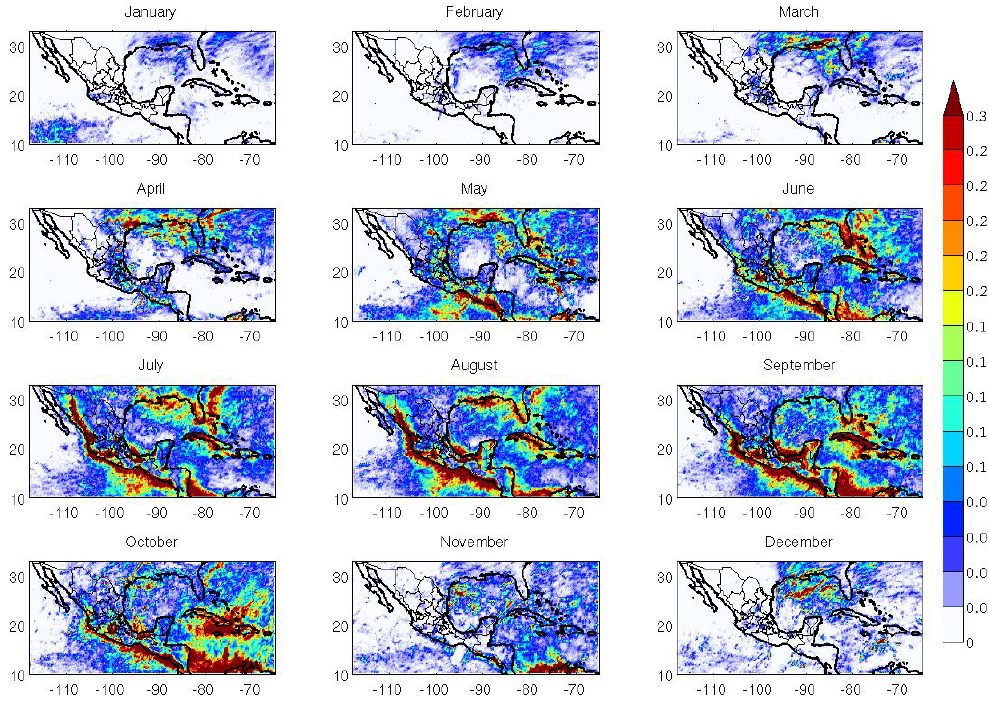
Fig. 3. Spatial distribution of cloud-to-ground strokes per month per km 2 , averaged over the five-year period (2005–2009).